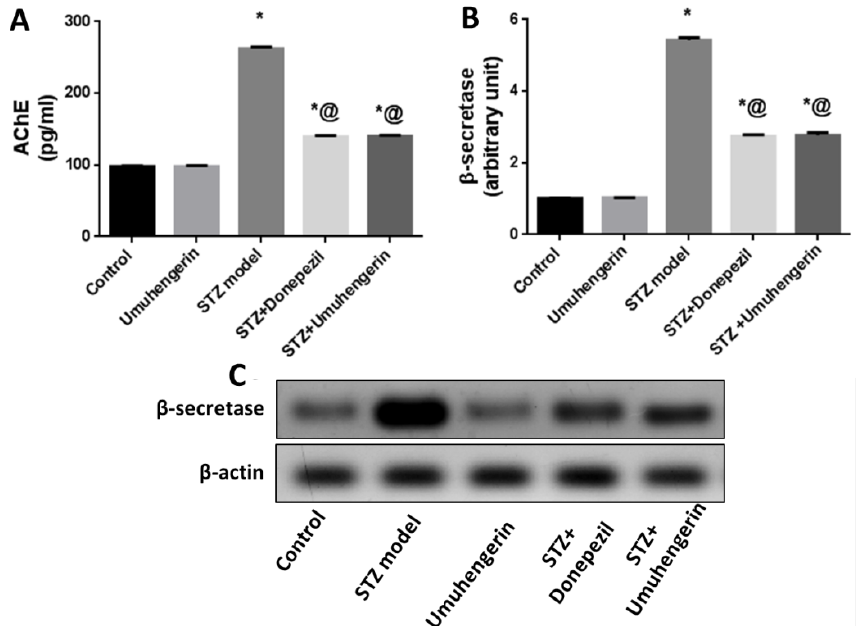
Figure 5. Effect of umuhengerin on an STZ-induced increase in ( A ) AChE activity and ( B ) β -secretase protein expression. ( C ) Western blot analysis of β -secretase. Values are expressed as mean ± SEM; n = 7. * p < 0.05 vs. control group, @ p < 0.05 vs. ICV-STZ group .